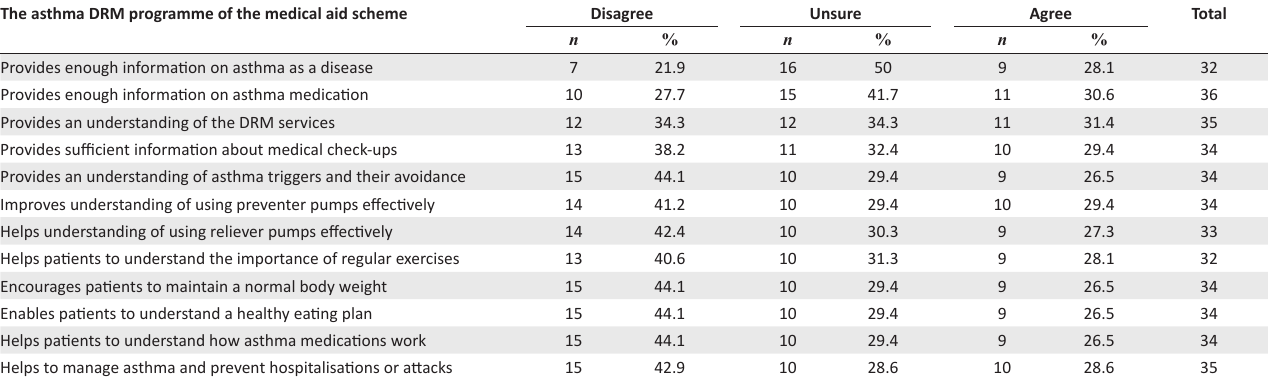
TABLE 1: Respondents’ perceptions regarding the asthma disease risk-management (DRM) programme of the medical aid scheme. The asthma DRM programme of the medical aid